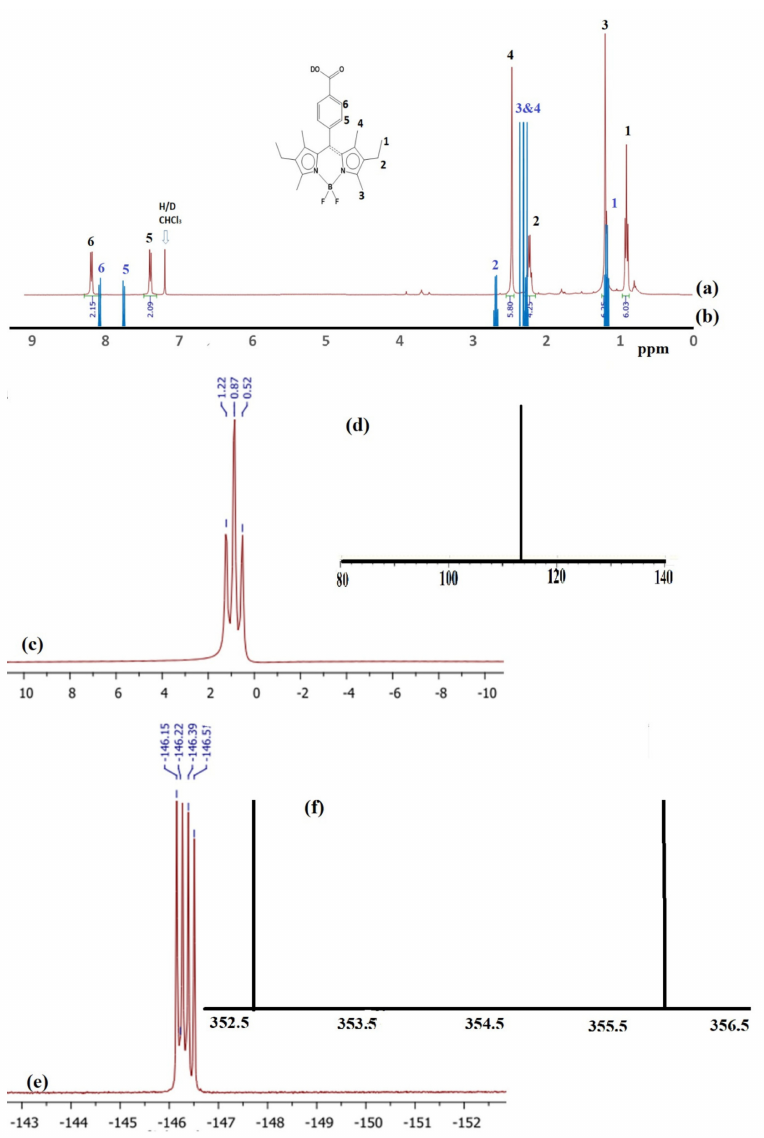
Figure 1. ( a ) Exp. 1 H and ( b ) NMRDB– 1 H-NMR, ( c ) 11 B-{ 1 H } and ( d ) GIAO-NMR, ( e ) 19 F-{ 1 H}- and ( f ) GIAO-NMR in CDCl 3